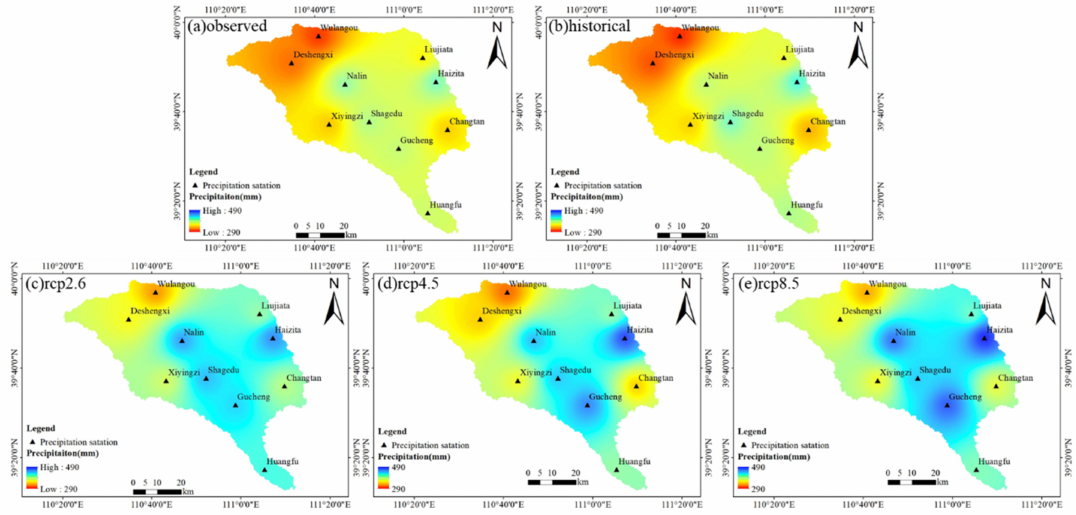
Figure 12. Comparison, in terms of spatial distribution of annual precipitation, between the observed data and the downscaled GCM data for ten precipitation stations in the Huangfuchuan Basin. The historical period is 1976–2005. The projection period is